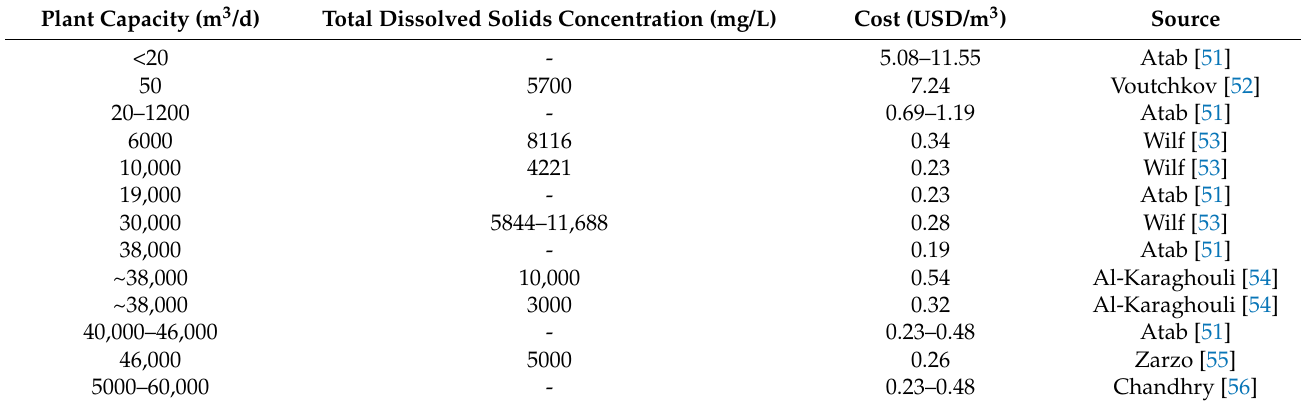
Table 4. OPEX cost data for various BWRO plants. Uncorrected for local inflation costs since construction. Plant Capacity (m 3